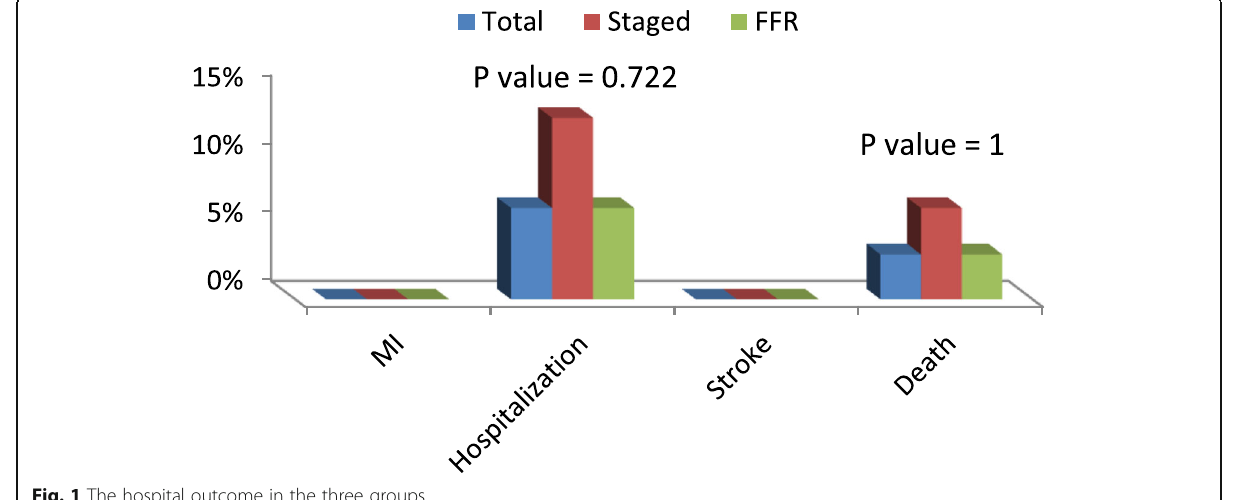
Table 1 The hospital outcome of the three groups. After the procedure was finished, the patient was put under observation for 3 – 5 days. There was only one patient who suffered renal impairment from the total group. Also, there were 5 patients from the staged group who experienced unstable angina during the hospital stay that was compared to 2 patients and only one patient in the total and FFR groups, respectively Total FFR P No. of